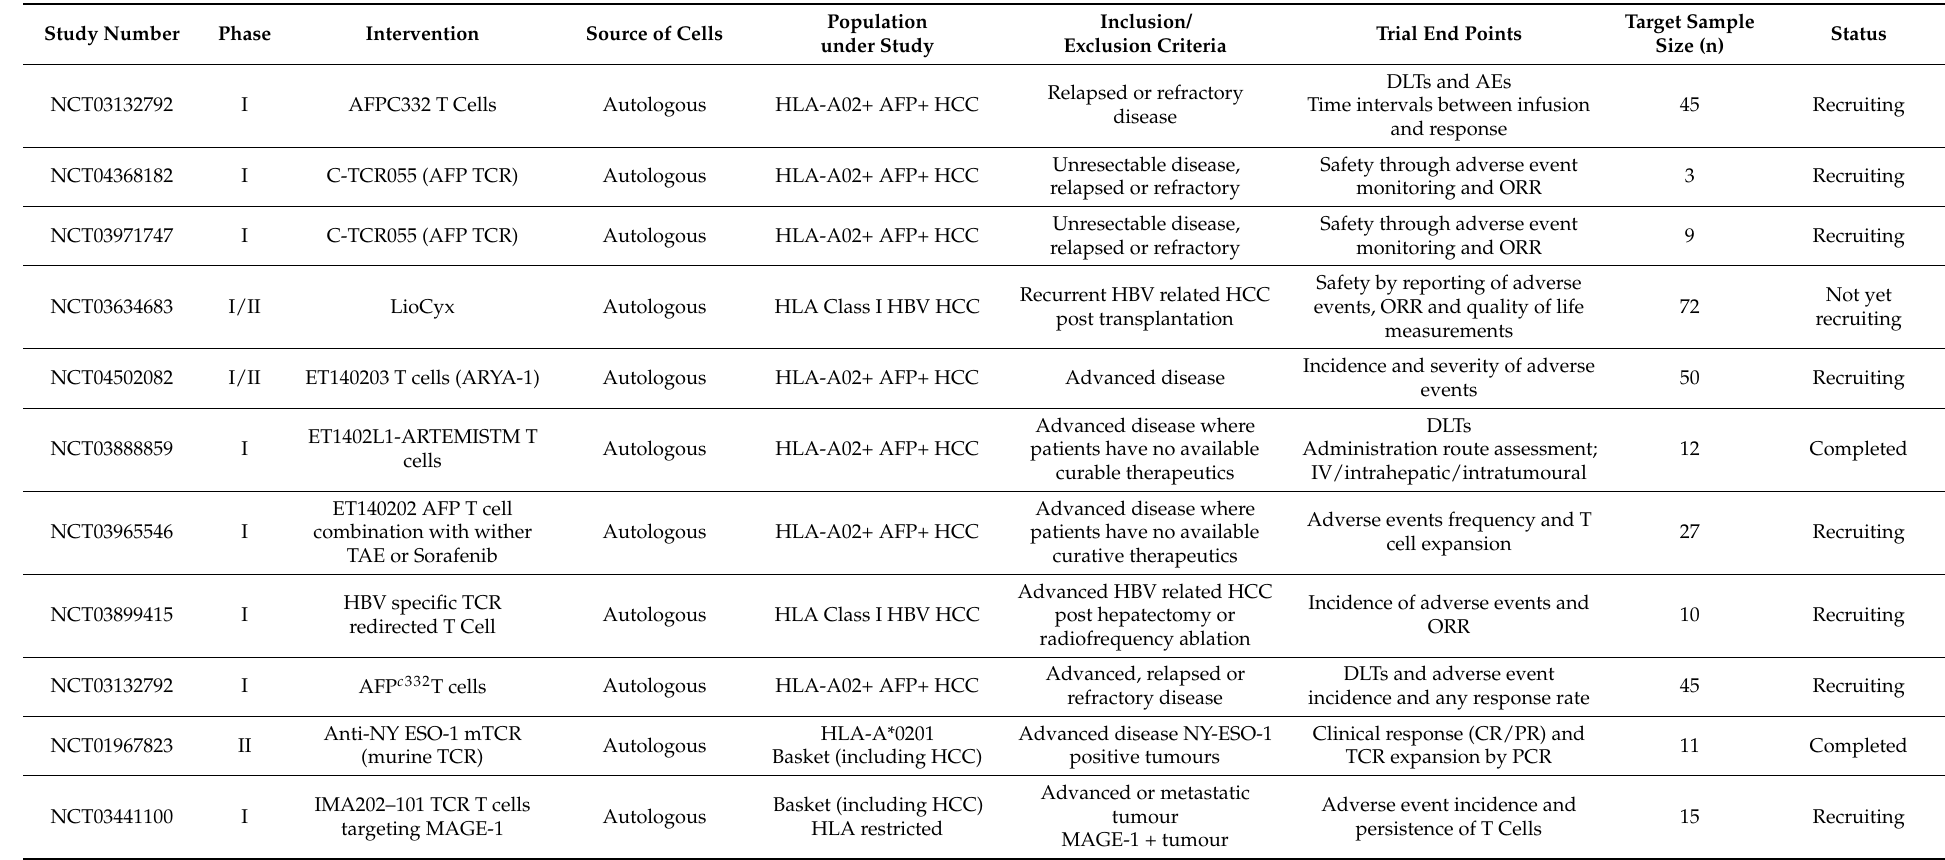
Table 2. TCR-T trials for HCC—only included trials with known status, all trials have been conducted in